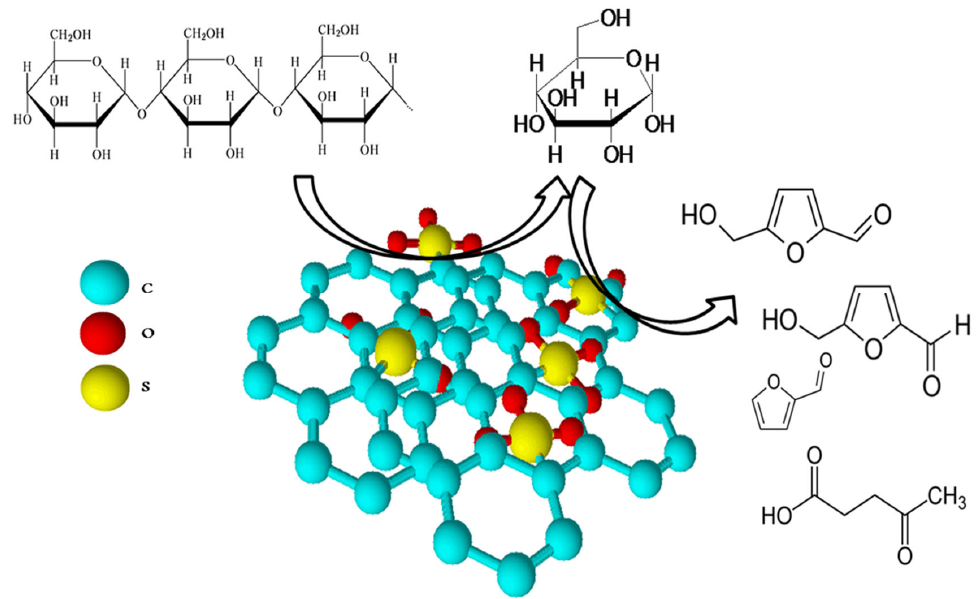
Figure 3. Application of acidic carbon ‐ based catalysts for biomass conversion. Summarized from [46–55].